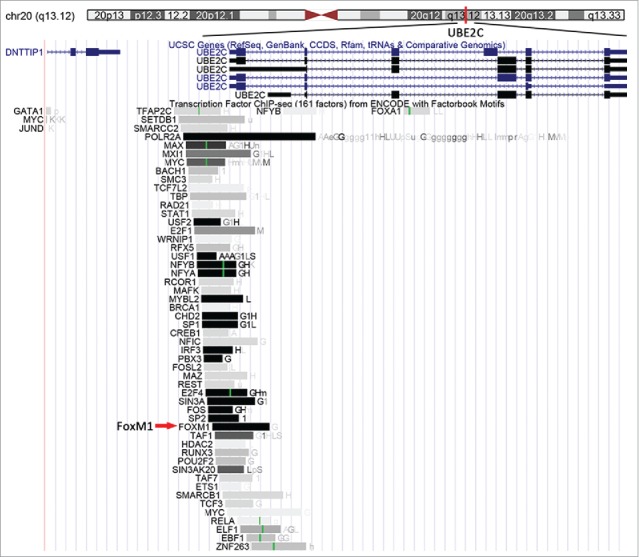
Predicted TFs, including FoxM1, are predicted to bind the UBE2C promoter region. The location of the UBE2C gene in the human genome is highlighted by the red bar. The FoxM1 transcription factor is indicated by the red arrow.